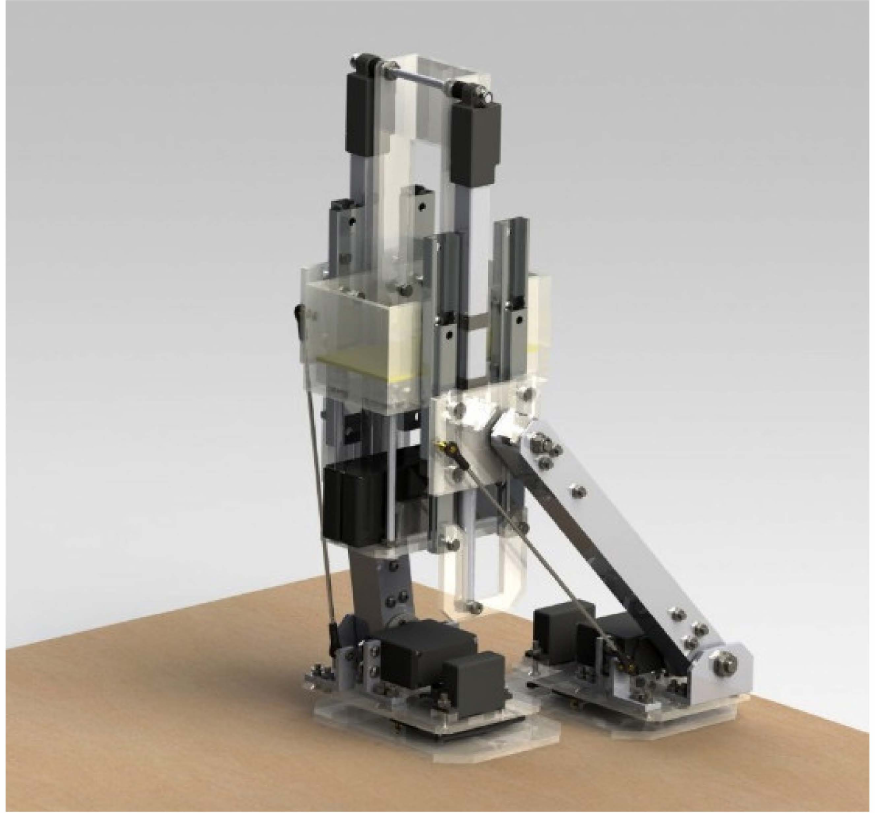
Figure 21. Designed biped robot with a vertically stabilized